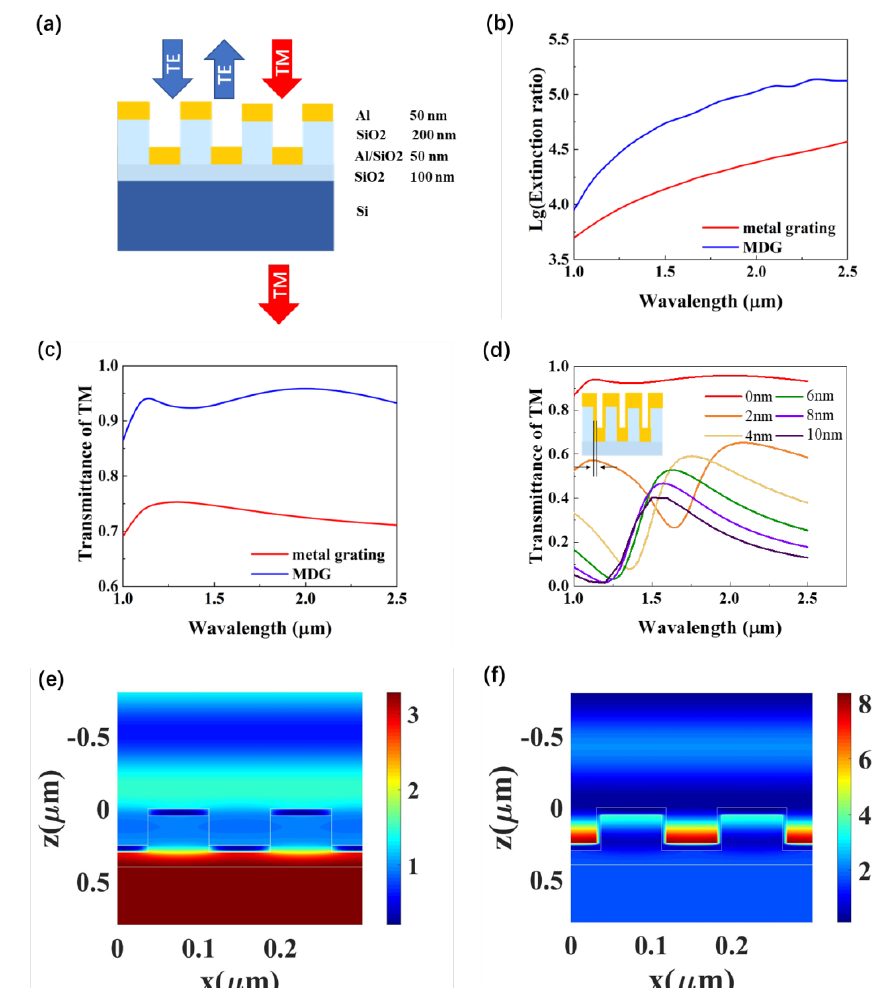
Figure 2. ( a ) MDG (metallic – dielectric grating) schematic. ( b ) Simulation results of extinction ratio (logarithmic scale) of MDG and normal metal grating. ( c ) Simulation results of TM transmittance of MDG and normal metal grating. ( d ) Simulation for TM transmittance with metals of different thicknesses covering the side walls. ( e ) Magnetic field intensity distribution diagram under TM mode without side wall metal covering (white line in the figure indicates the MDG structure). ( f ) Magnetic field intensity distribution diagram under TM mode with side wall metal covering (the white line in the figure indicates the MDG structure with side wall metal covering).